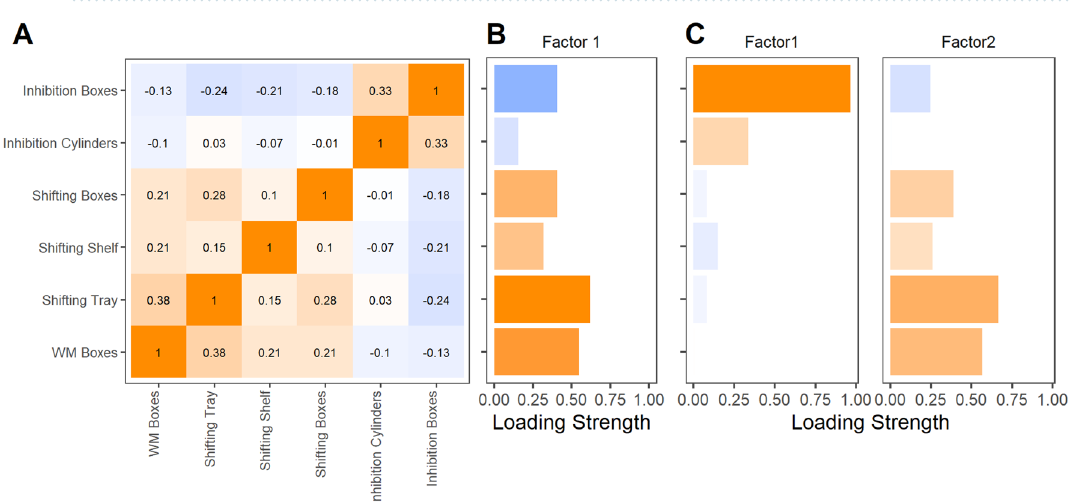
Figure 3. The Pearson correlation matrix ( A ) and the loading strength of all eight tasks (mean centered by site and standardized across sites) that were included in the 1-factor ( B ) exploratory factor analysis (EFA), and for comparison the 2-factor EFA ( C ) for the child sample. Positive values are depicted in orange, negative values in blue. Only participants that completed all eight tasks are included in these analyses (n = 95).